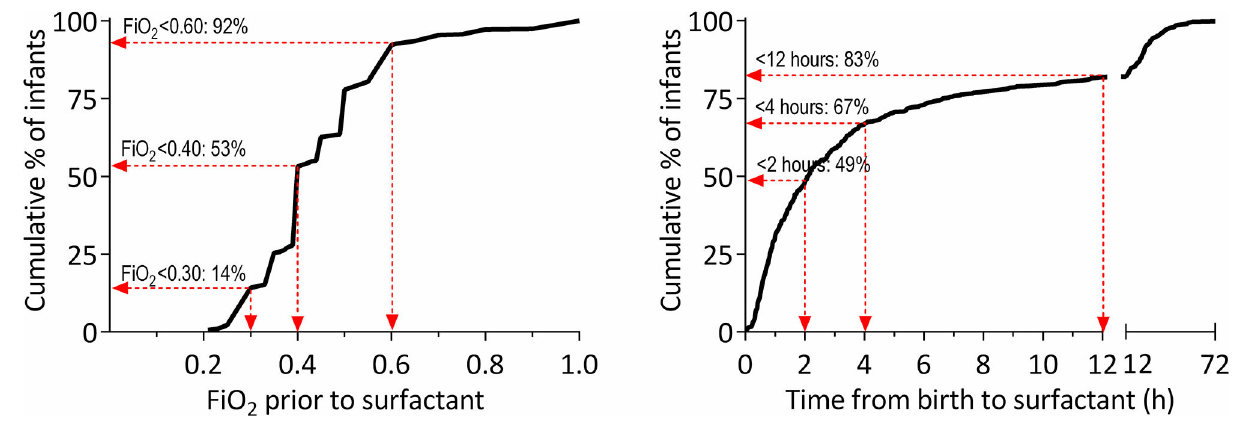
FIGURE 1 | Histogram of cumulative distribution of FiO 2 prior to SF (left) and time to SF